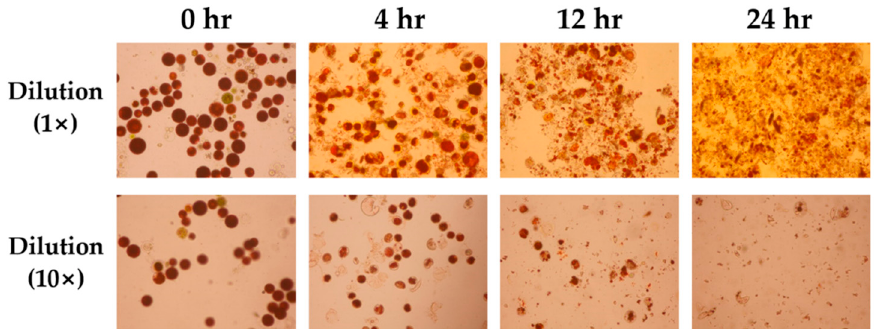
Figure 6. Morphological change of H. pluvialis cysts after mechanical pretreatment of ball mill for 12 h.